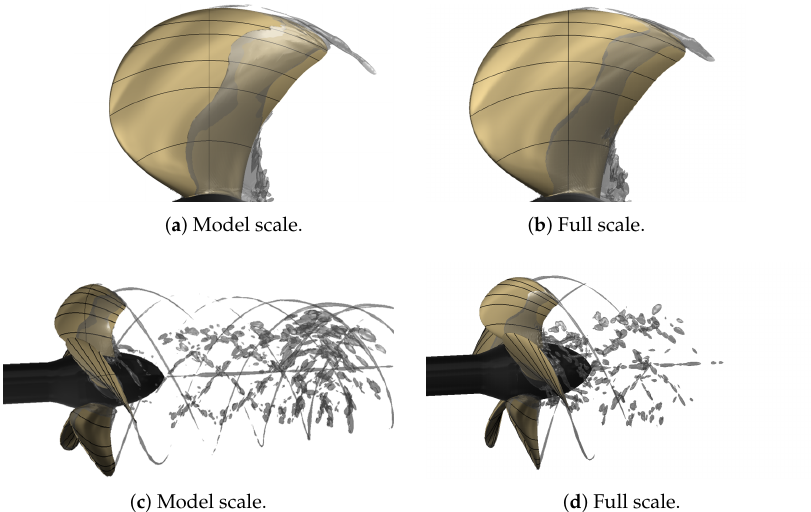
Figure 26. Comparison of the predicted cavitation patterns for the PPTC Case 2 in model- and full-scale conditions. Both results are from DDES.